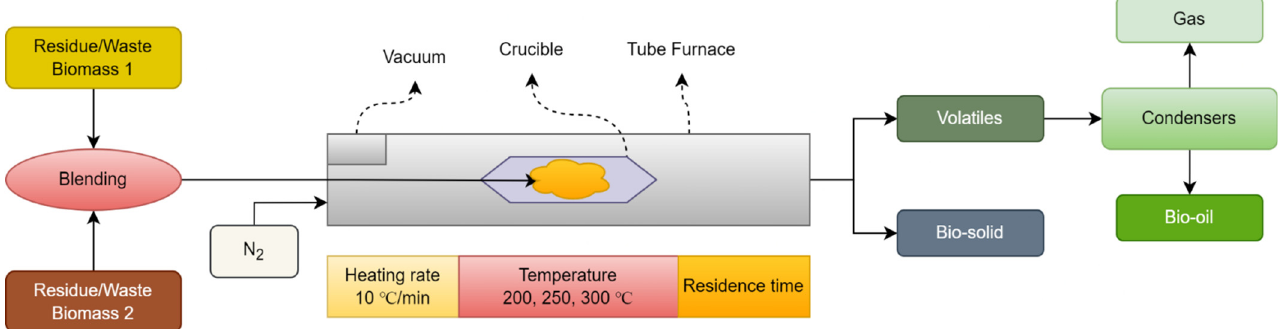
Figure 3. Co-torrefaction